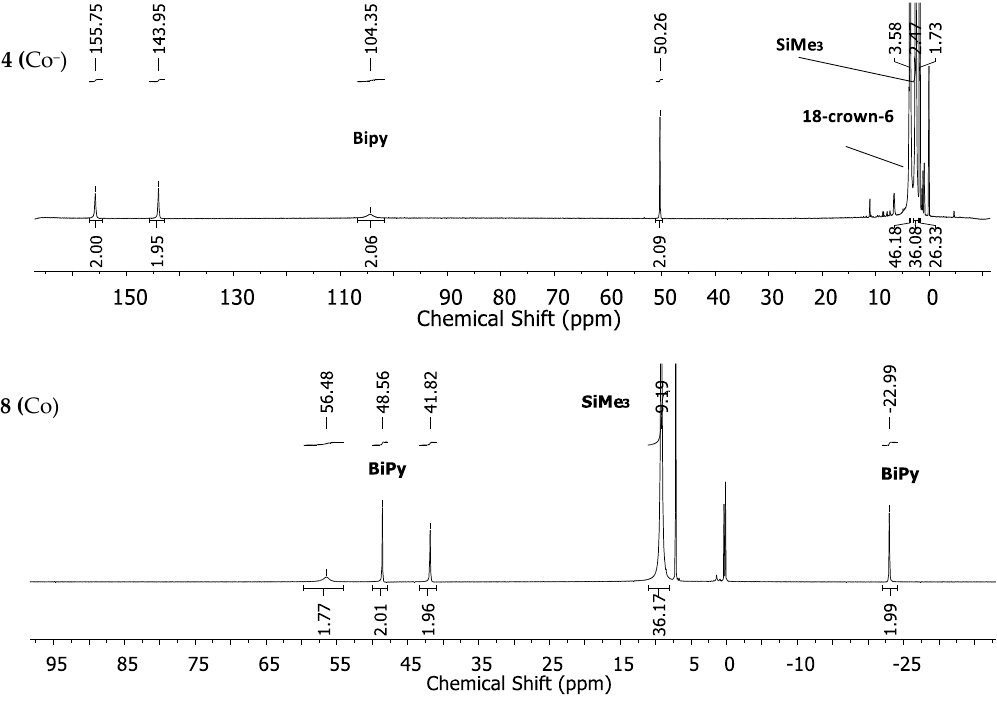
Figure 4. 1 H-NMR spectra of the cobalt complexes 4 (Co − ) (top) and 8 (Co) (bottom) in THF-d 8 . The proton signals of the bipyridine ligand of the reduced Zn complex 10 (Zn − ) are shifted to a higher field in comparison to their position found for the diamagnetic, neutral derivative 9 (Zn). The signals are moderately broadened and show reduced intensity. Table 3. 1 H-NMR spectroscopic features of the compounds 1 − 10 in THF-d 8 (500 MHz). Complex δ (SiMe 3 )/ppm (w ½ /Hz)